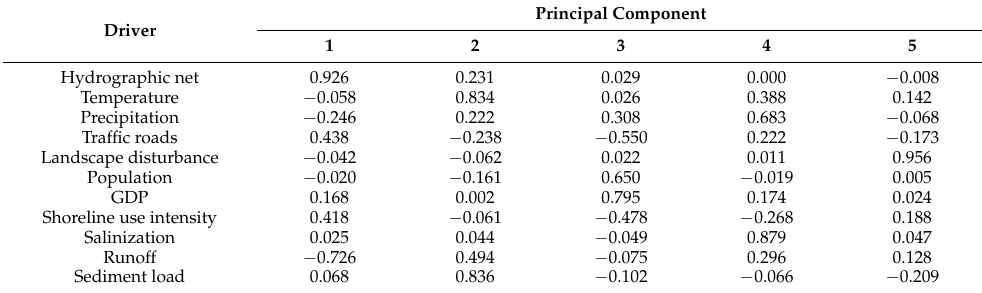
Table 7. Component